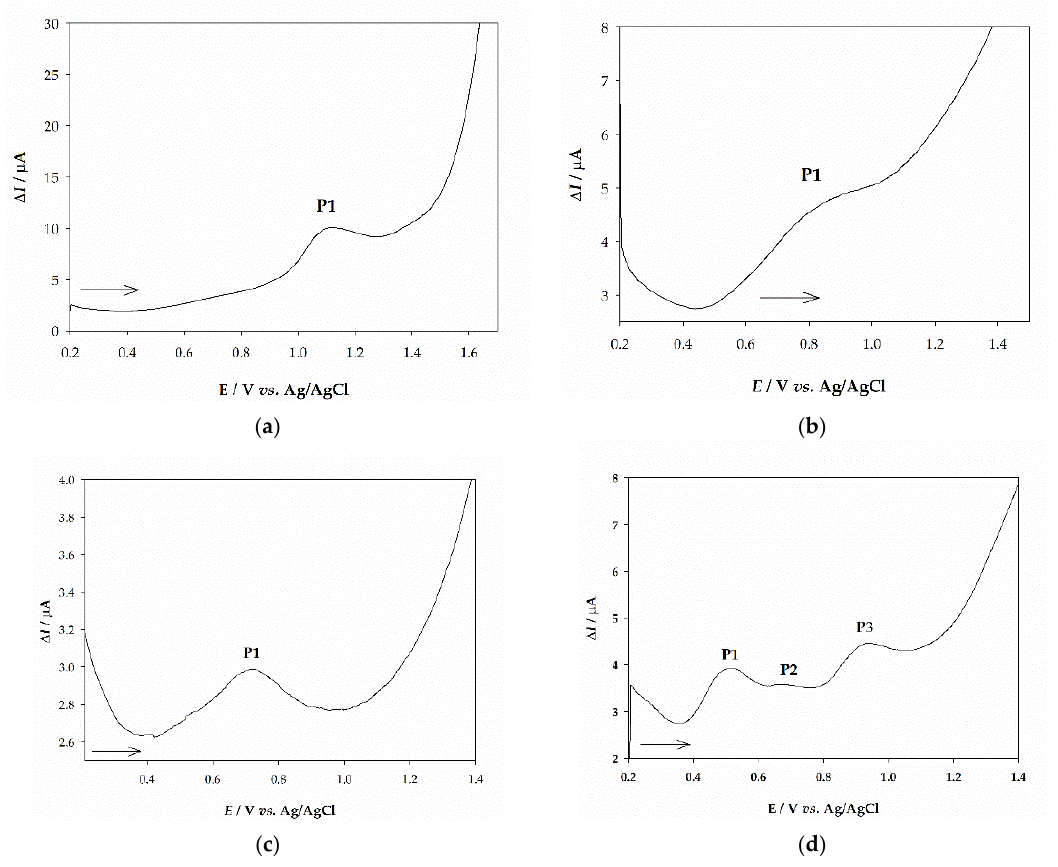
Figure 6. Square-wave voltammograms (SWV) of supercritical CO 2 extracts obtained from four medicinal plants: ( a ) Chamomile; ( b ) Yarrow; ( c ) St. John’s wort; ( d ) Curry plant in the form of microfilm immobilized on the surface of glassy carbon electrode (GCE) and immersed in Britton Robinson buffer (pH 2.5). The experimental conditions are as depicted in Figure 5.